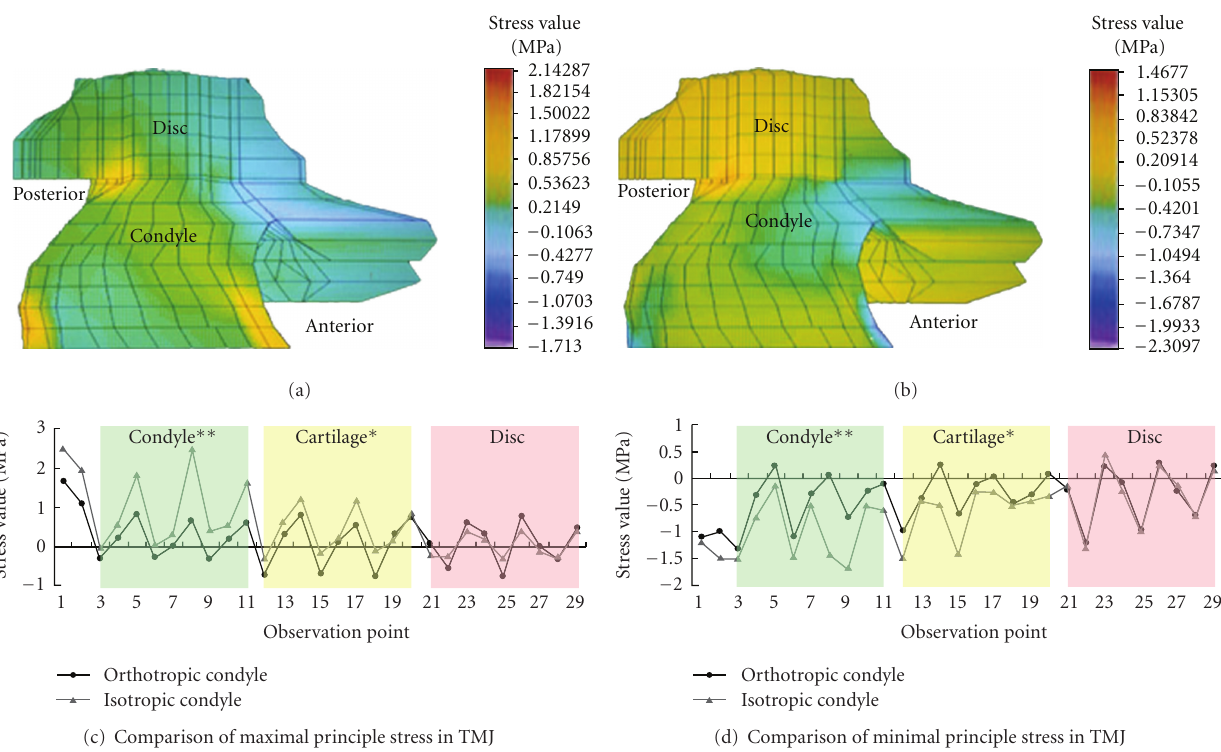
Figure 3: Distribution map of the maximal principal stress (a) and the minimal principal stress (b) in the TMJ with orthotropic properties. The pictures show us that the stress uniformly transferred from the surface to the central part of the orthotropic condyle. Stress of the anterior part of the TMJ was mainly compressive and that of posterior part was mainly tensile (the cartilage could not be seen clearly from this direction). Comparisons of the maximal principle stress and the minimal principle stress in TMJ between the finite element analysis model with an orthotropic condyle and isotropic condyle were marked in (c) and (d), in which black curve corresponded with data based on the orthotropic model and the multicolored curve with data based on the isotropic model. It showed that stress values in the condylar neck (point 1, 2), condyle (points 3–11), and cartilage (points 12–20) of the isotropic model were higher than those of the orthotropic model (with ∗∗ indicating P < . 01 and ∗ indicating P < . 05), whereas values in the disc of the both models showed no di ff erences (points